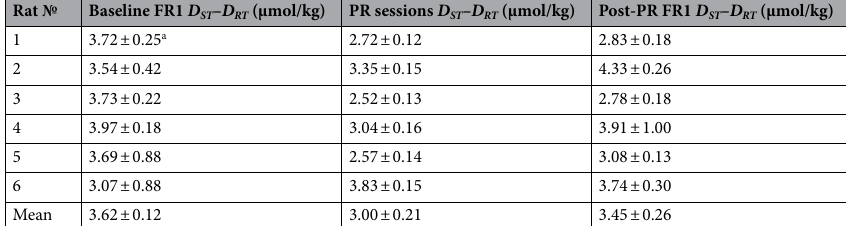
Table 3. Calculated compulsion zone width in individual rats. a Mean ± SEM.